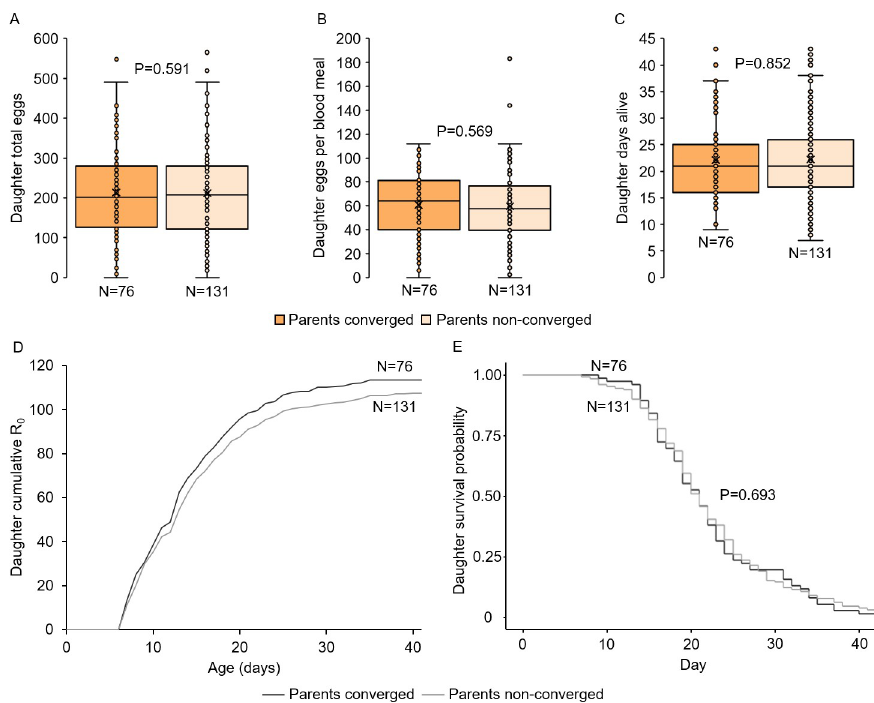
Fig 3. Parental harmonic convergence does not signal daughter lifetime fecundity and life history parameters. Neither daughter fecundity (A and B) nor longevity (C) differed by parental harmonic convergence status (P � 0.569 for all comparisons). Daughter reproductive rate (D) and survival (E) also did not differ by parental convergence status. Graph displays sample size (N) and LMM (A–C) or Cox frailty model (E) P-values for each comparison. For details on daughter life table analysis data, see S1 Table. Survival data shows Kaplan-Meier curves for daughters across the duration of the life table study.